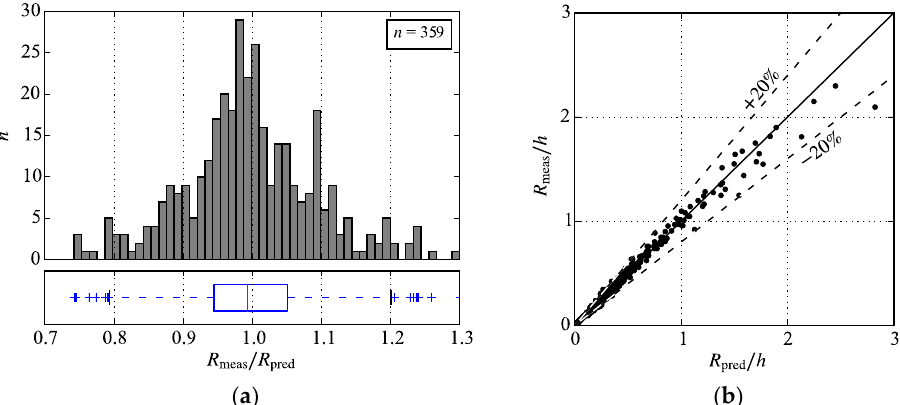
Figure 11. ( a ) Histogram and boxplot with whiskers at 2.5th and 97.5th percentile of measured over predicted (Equation (9)) runup heights R meas / R pred and ( b ) measured versus predicted runup heights R over stillwater depth h of the overall dataset.